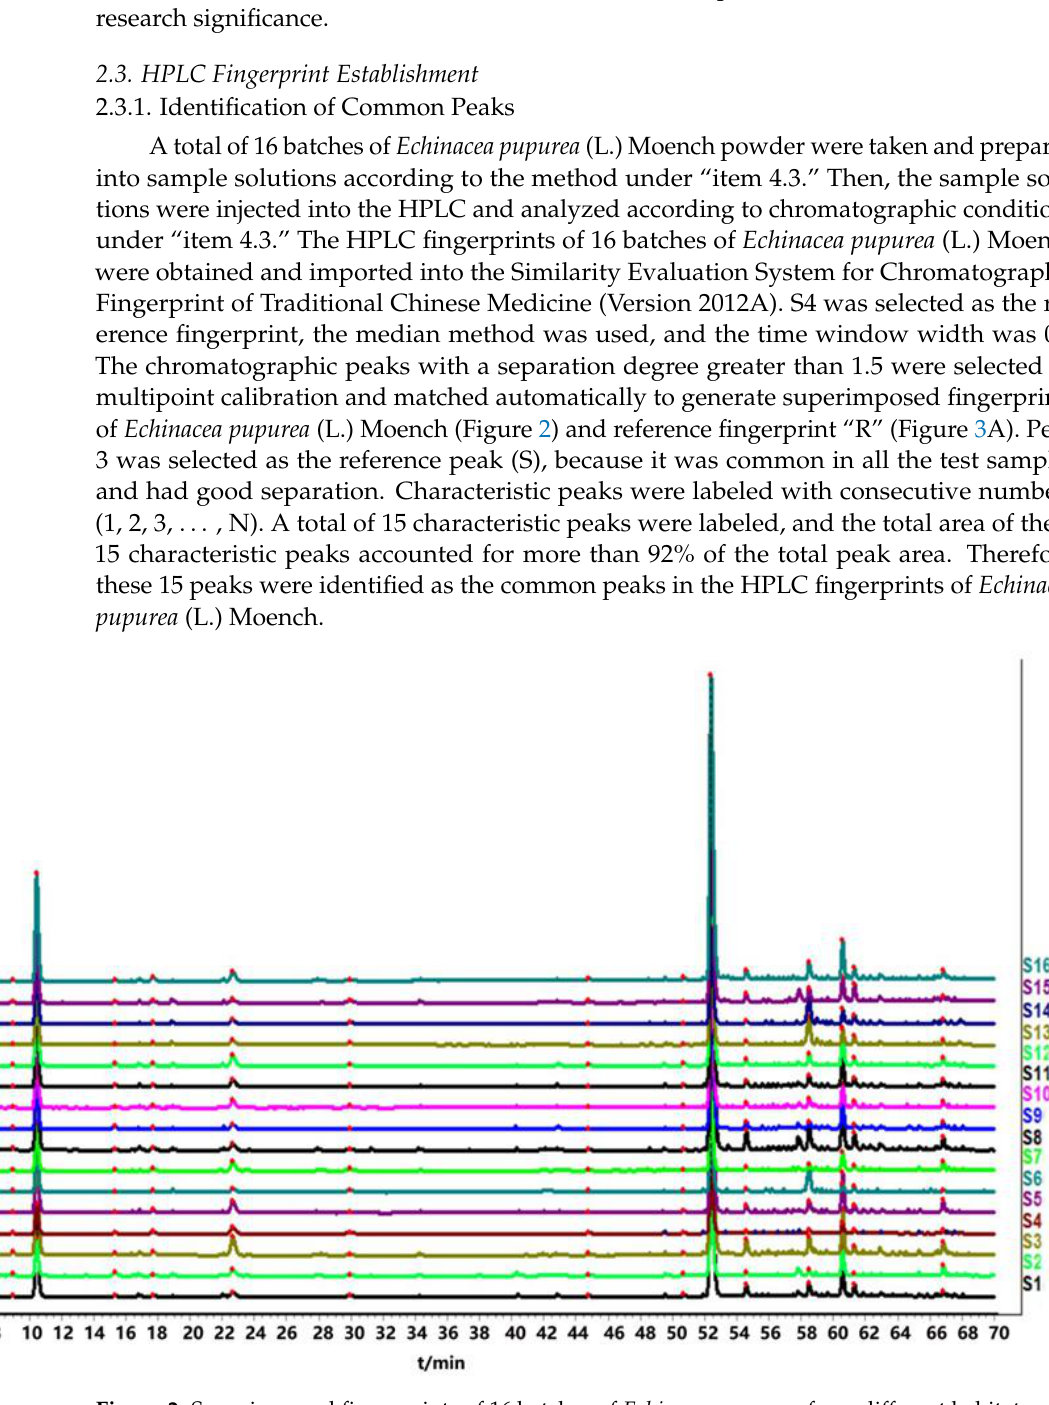
Figure 3. HPLC diagram of control fingerprint”R” ( A ) and mixed control solution ( B ) of Echinacea purpurea (L.) Moench: (3) caftaric acid, (4) chlorogenic acid, (10) Cichoric acid.